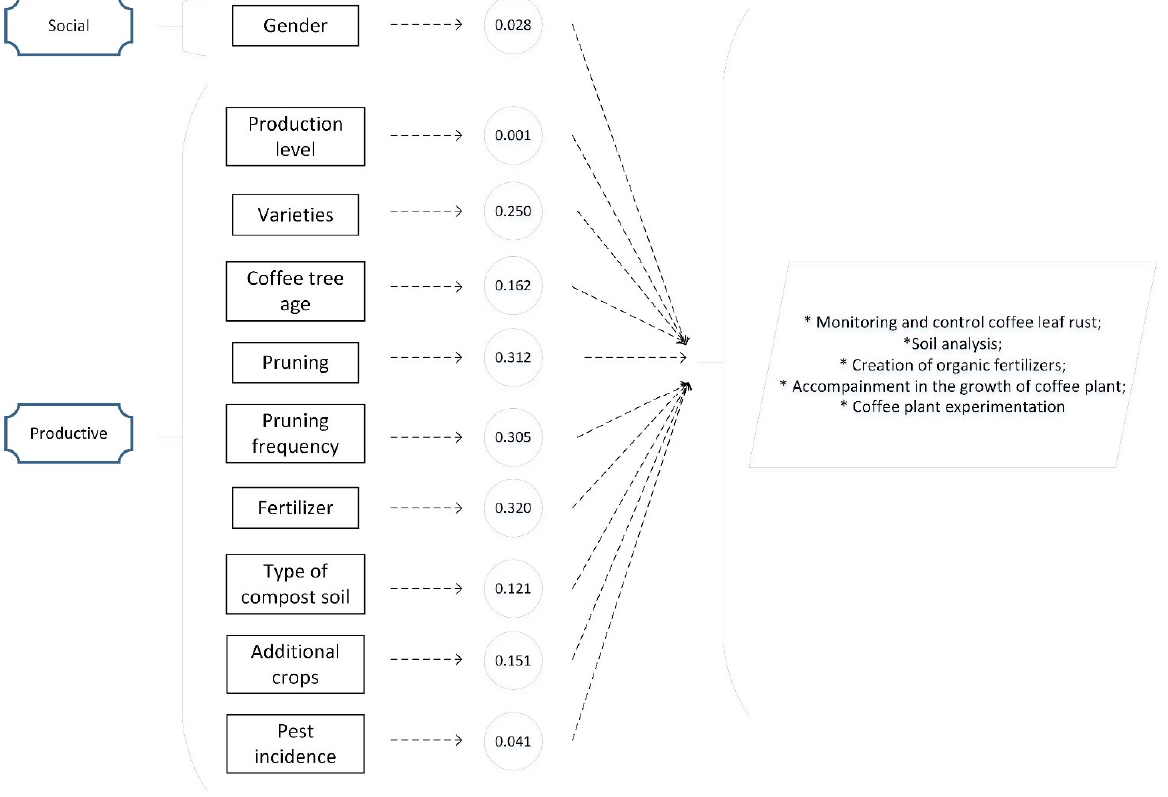
Figure 4. Positive statistical correlations. Table 6. Results of statistical